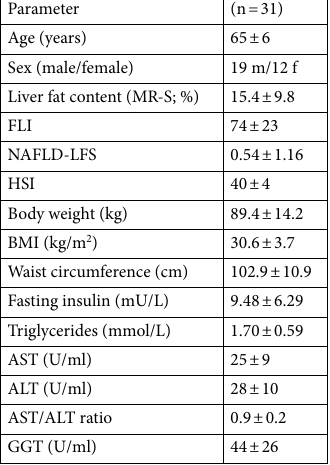
Table 1. Baseline characteristics. ALT alanine aminotransferase, AST aspartate aminotransferase, GGT gamma-glutamyltransferase, FLI fatty liver index, HSI Hepatosteatosis Index, NAFLD-LFS Non-alcoholic fatty liver disease-liver fat score; no significant differences between both groups.